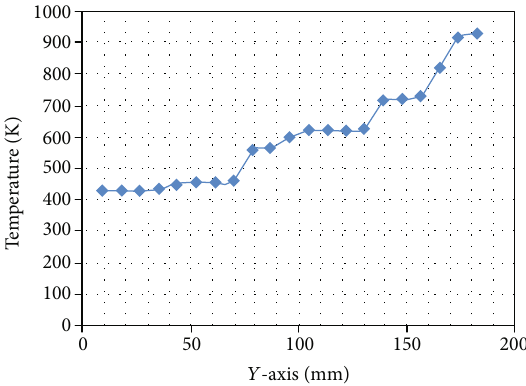
Figure 7: Temperature distribution with position along with the burner.